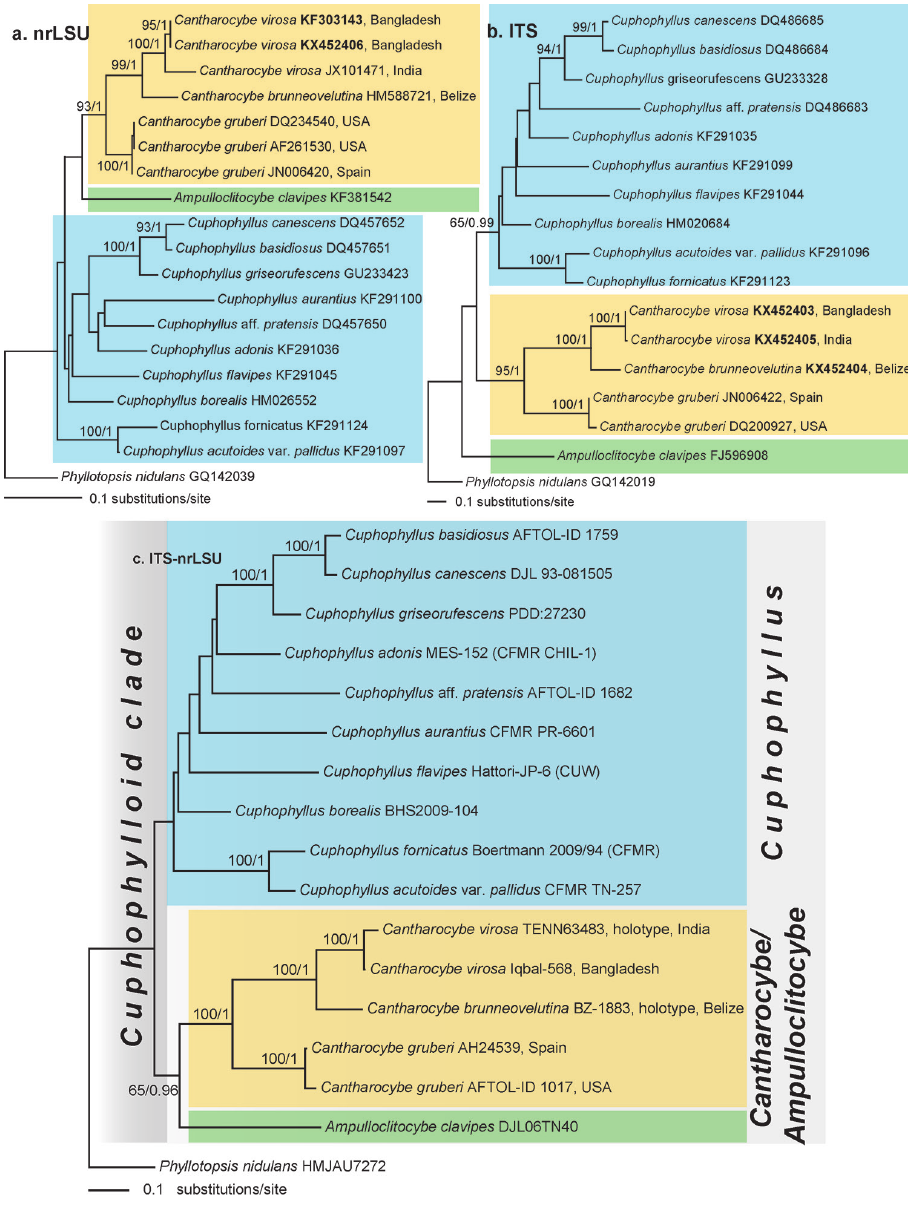
Figure 1. Phylogenetic relationships of the genus Cantharocybe inferred from nrLSU ( a ), ITS ( b ) and ITS+nrLSU ( c ) sequences using maximum likelihood (ML). RAxML bootstrap supports values (>50%) and Bayesian posterior probabilities (>0.95) are indicated on the branches at nodes (ML/PP). Newly generated sequences are highlighted in bold. GenBank accession or voucher numbers are provided after the species